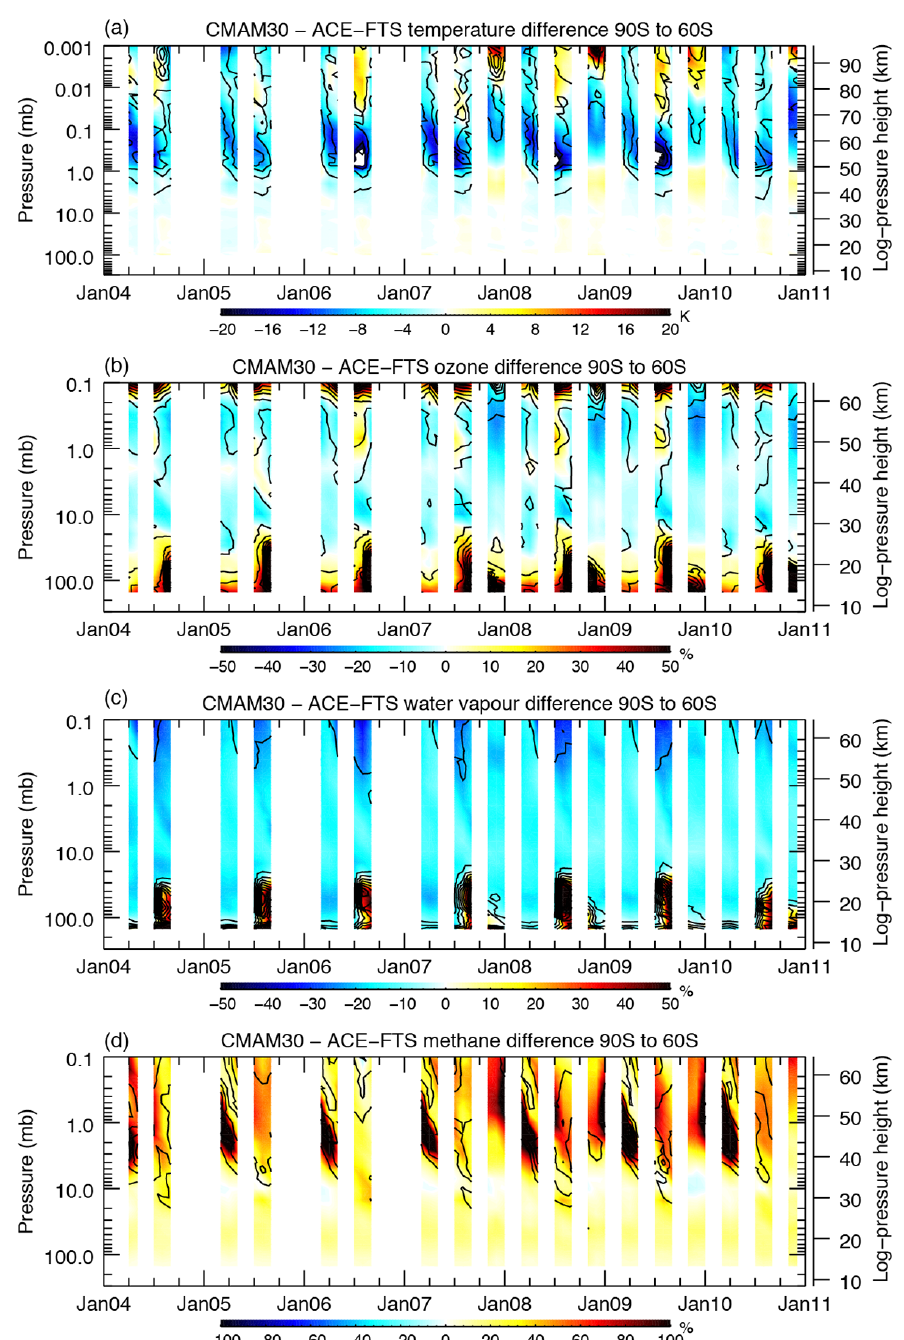
Figure 9. Time series of absolute differences for temperature (a) of coincident profiles between CMAM30 and ACE-FTS for 90 to 60 ◦ S and for relative differences for ozone (b) , water vapour (c) and methane (d). Colours indicate the median bias of CMAM30 data. Contours indicate the MAD with a contour interval of 2K for temperature and 5% for